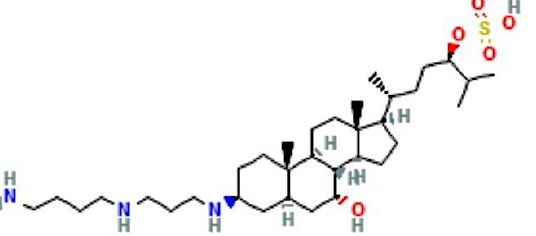
Figure 1. Squalamine, a 7,24 dihydroxylated 24-sulfated cholestane steroid conjugated to a